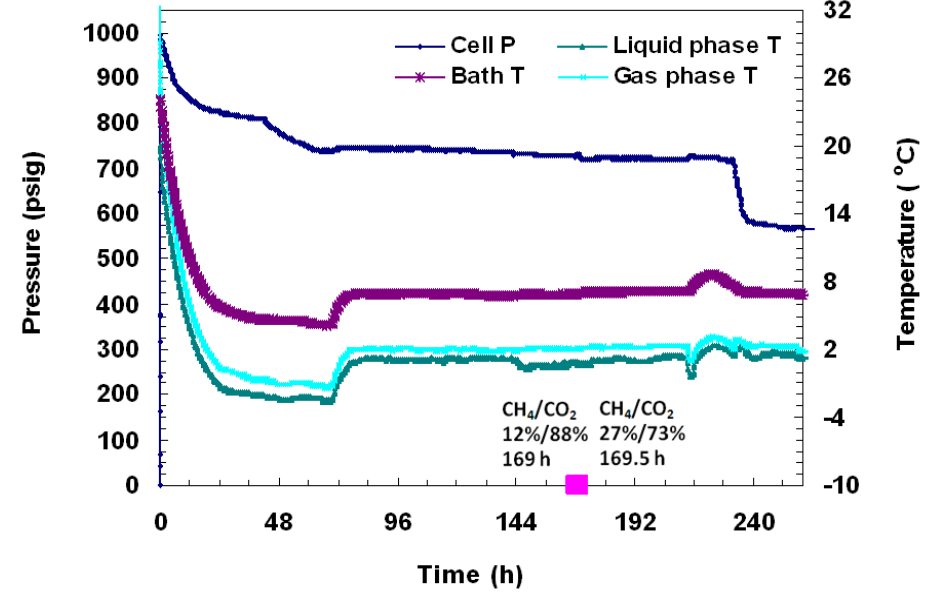
Figure 8. A plot of P/T versus time during charging and hydrate formation in Run 4. Hydrate formation was achieved from a CH represent gas compositions measured by analyzing gas samples at corresponding